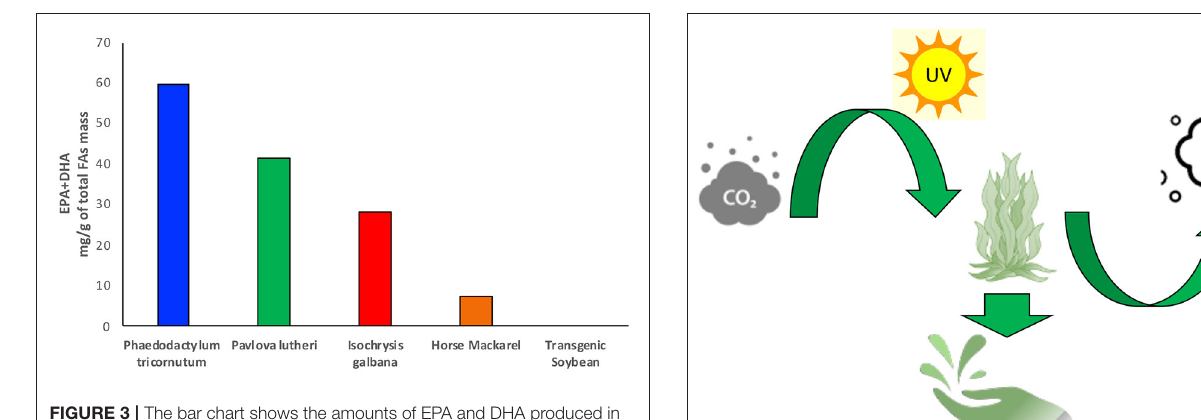
aquatic environment in a very finely regulated manner (53).